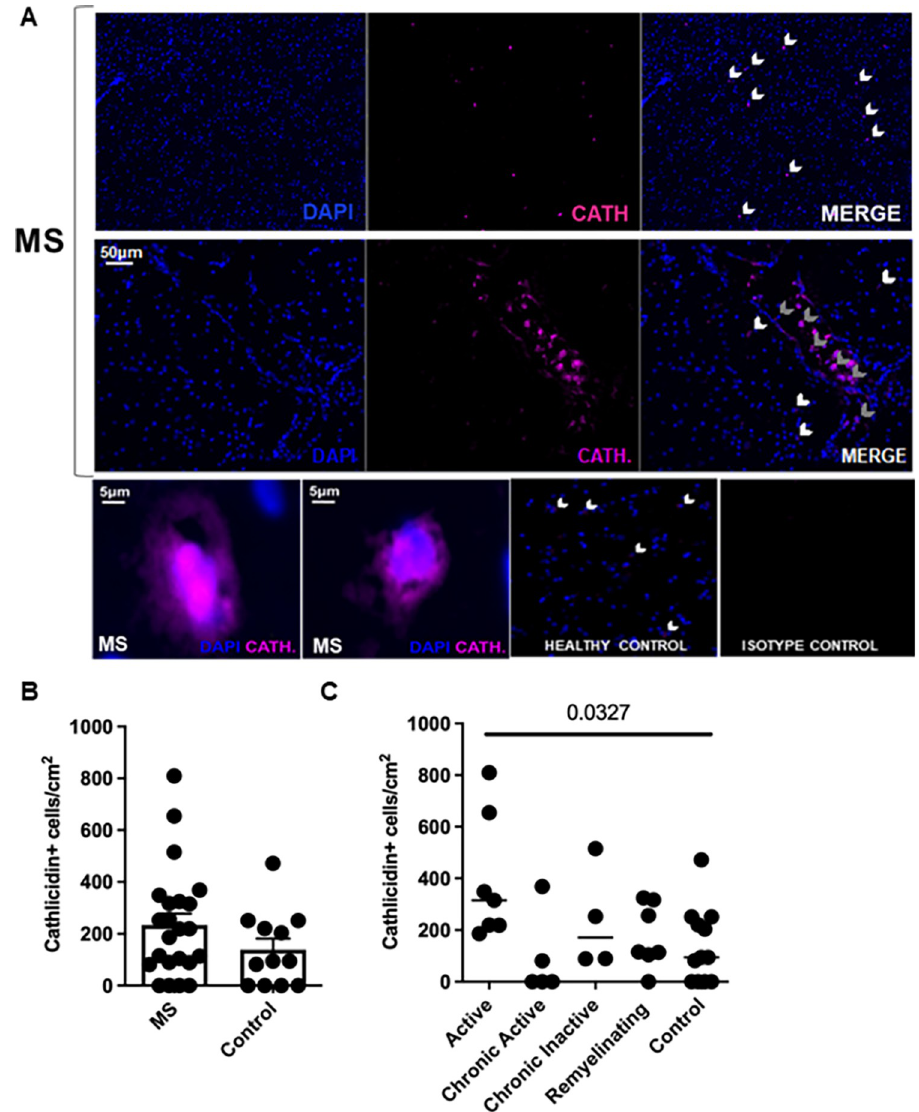
Fig 3. Cathelicidin is produced in the healthy and inflamed human brain. Postmortem brain sections were obtained from patients who died of MS and control patients with no neurological disease. (A-C) Cathelicidin (Cath.) production was quantified using immunofluorescent imaging. Grey arrowheads indicate cathelicidin within blood vessels, and white arrowheads indicate cathelicidin outside vessels. Data shown are (B) mean with error bars showing standard error and (C) individual data points with line at median. Statistical test used: in (C)–one way ANOVA. N values: B and C– 7 patients in MS group and 3 patients in control group, each data point represents an area of the brain analysed. Images in (A) are representative of at least 3 patients. Patient information is listed in S3 Table. Data available at 10. 6084/m9.figshare.20310363. cath, cathelicidin; MS, multiple